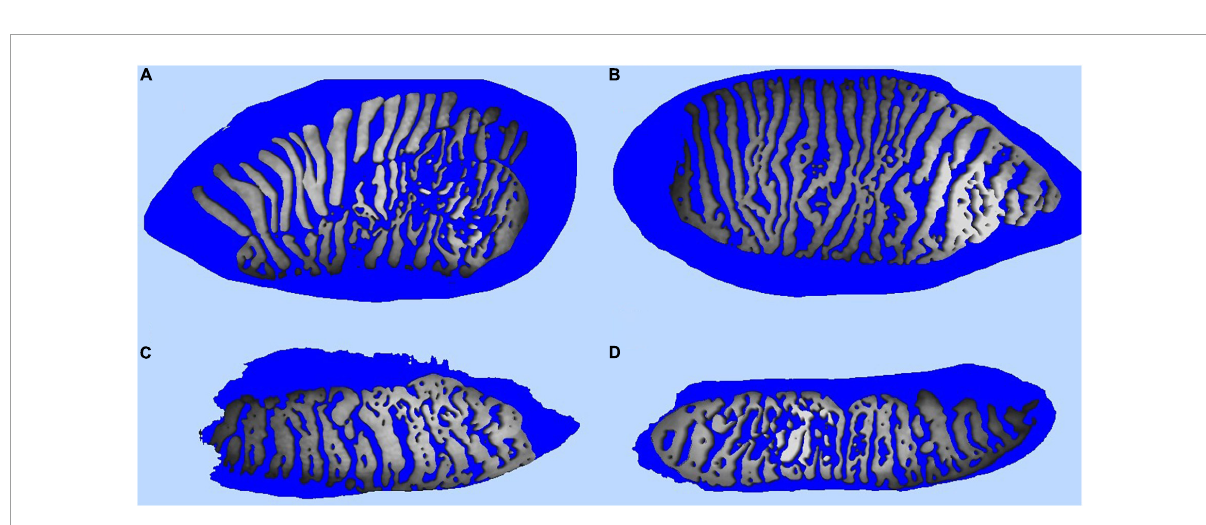
FIGURE7 Simulated 3D meibomian gland pattern performed with the intranet software of the Integrated Clinical Platform (ICP) within the Ocular Surface Analyzer (OSA) from SBM System R (cid:13) (Orbassano, Torino, Italy). (A) Simulated 3D right eye upper eyelid real meibomian gland pattern. (B) Simulated 3D left eye upper eyelid real meibomian gland pattern. (C) Simulated 3D right eye low eyelid real meibomian gland pattern. (D) Simulated 3D left eye low eyelid real meibomian gland